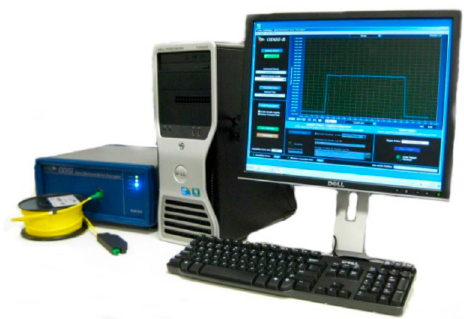
Figure 1. ODiSI-B series from Luna Innovations Inc.